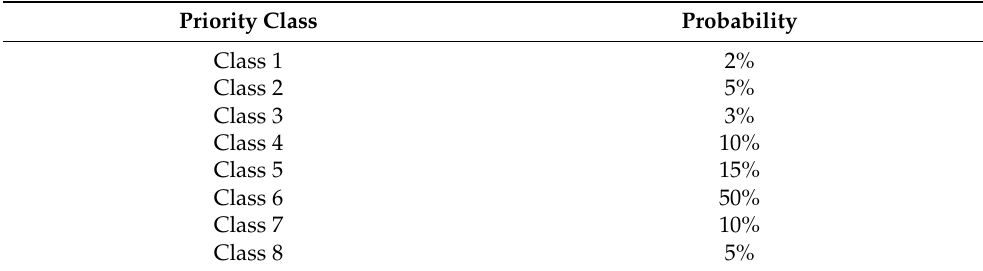
Table 3. Probability in the selection of a priority for a